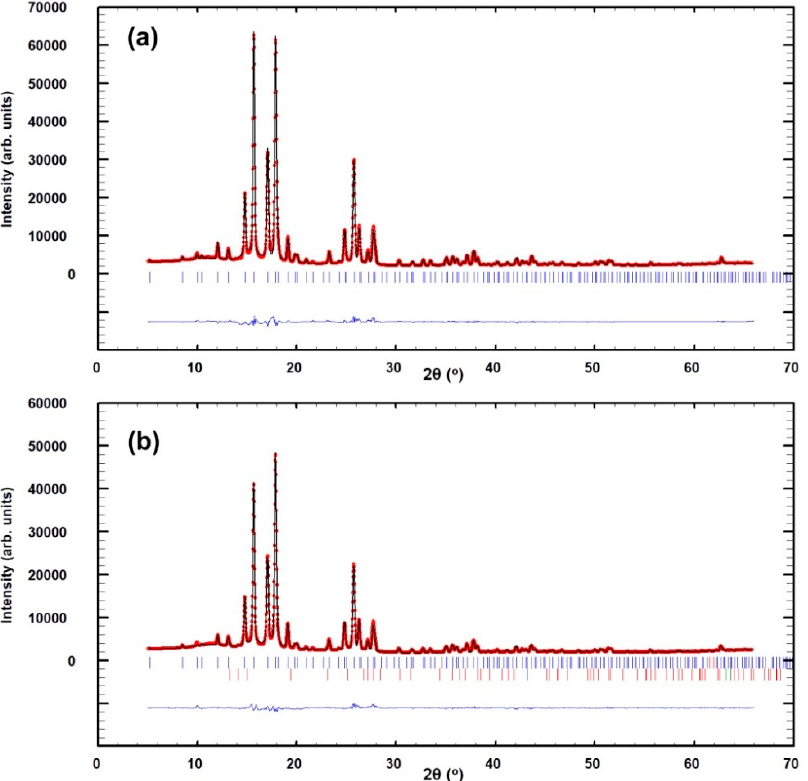
Figure 1. ( a ) Rietveld refinement of the THF + O 2 hydrate pattern. Space group: Fd-3m ; Lattice parameter: a = 17.1143 (5) Å; Reliability factors: χ 2 = 5.68; and R wp = 8.55% (background subtracted); ( b ) Rietveld refinement of the 3-OH THF + O 2 hydrate pattern (tick marks: first row for sII hydrate, second row for ice I h ). Space group: Fd-3m ; Lattice parameter: a = 17.1268 (5) Å; Reliability factors: χ 2 = 3.65; and R wp = 8.38% (background subtracted).